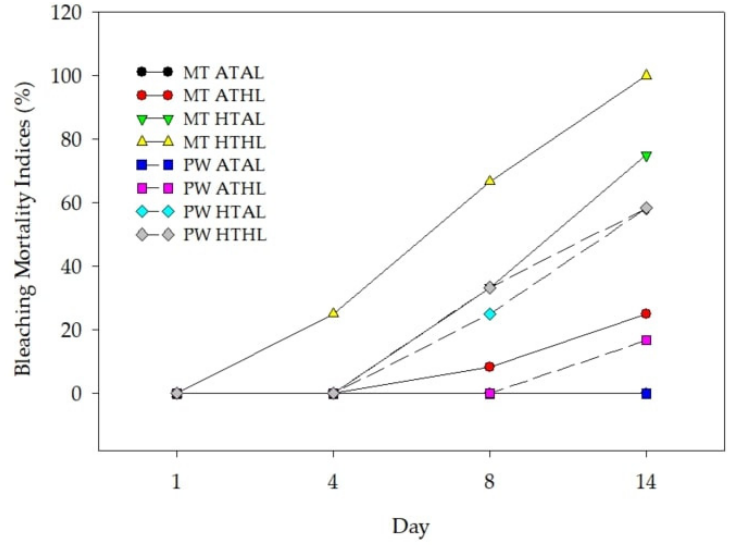
Figure 6. Bleaching Mortality Indices (BMIs; %) of P. acuta from MT and PW at each sampling time (n = 4).